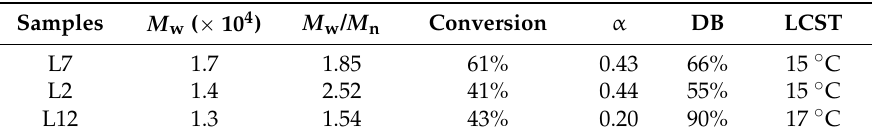
Table 5. Effect of DB% on LCST of